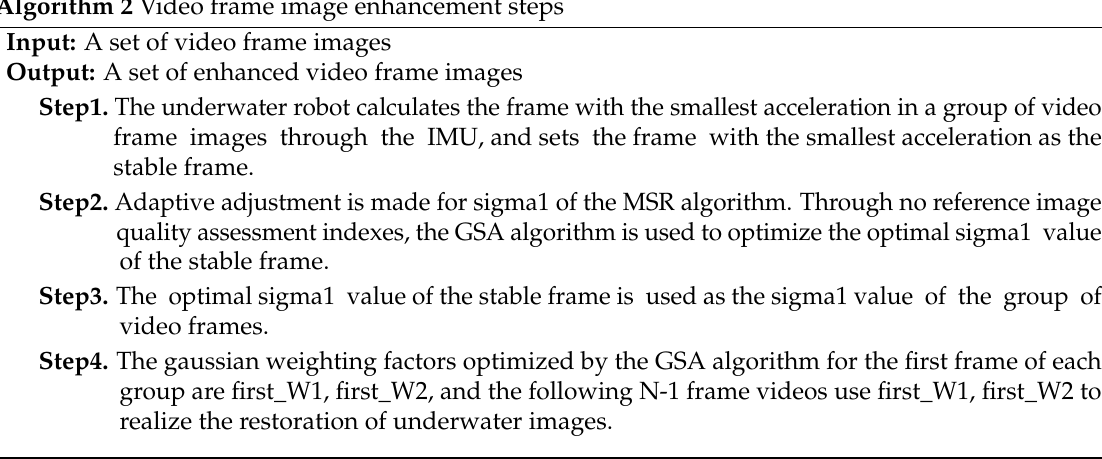
Algorithm 2 Video frame image enhancement steps